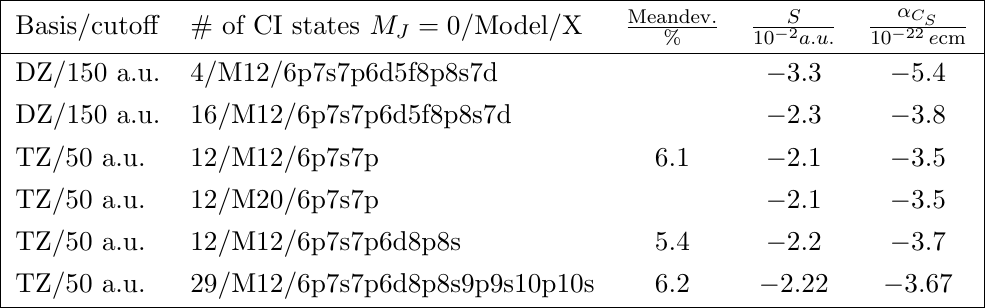
Table 1 . S-PS-ne interaction ratio S for the 1 S 0 ground state of the 199 Hg isotope, I = 1 = 2, (cid:22) ( 199 Hg) = +0 : 5058855 [24], E Ext = 0 : 00024 a.u. ; CI models M12: 12 electrons correlated,